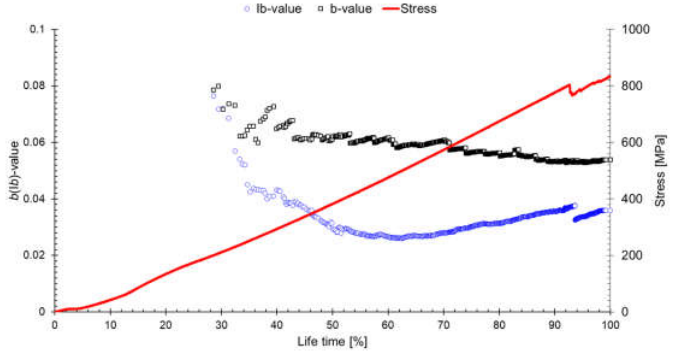
Figure 9. Lifetime dependency of the b - and I b -values.